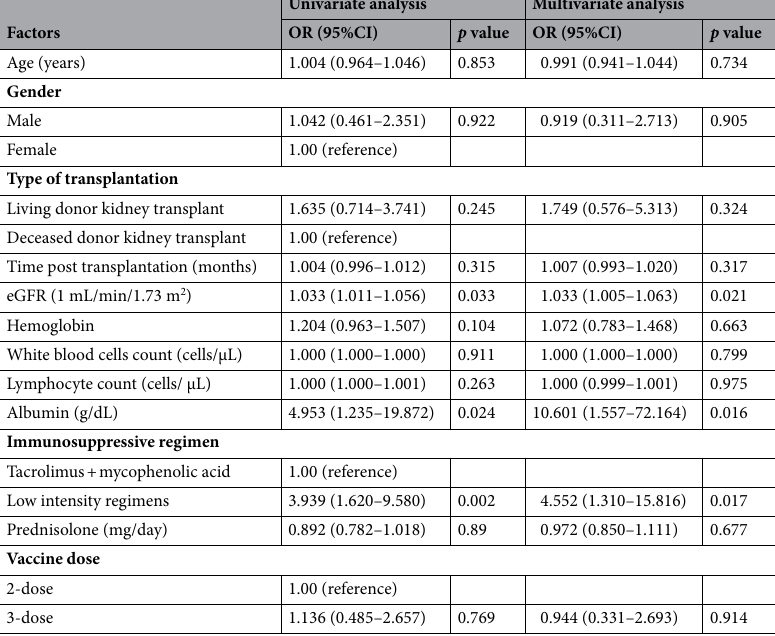
Table 4. Univariate and multivariate analysis of factors associated with seroconversion of hepatitis A vaccination in both groups (n = 93). eGFR; estimated glomerular filtration rate by